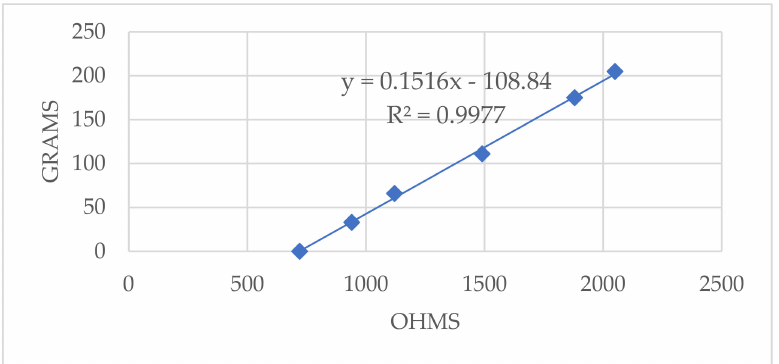
Figure 11. Results of the sensor characterization tests for the elaboration of the Resistance–Weight function with the equation of the line and correlation